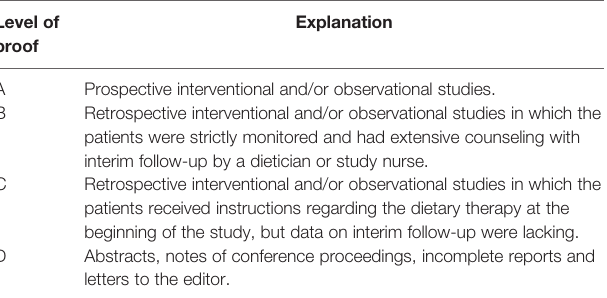
TABLE 1 | Level of proof of the pediatric EoE